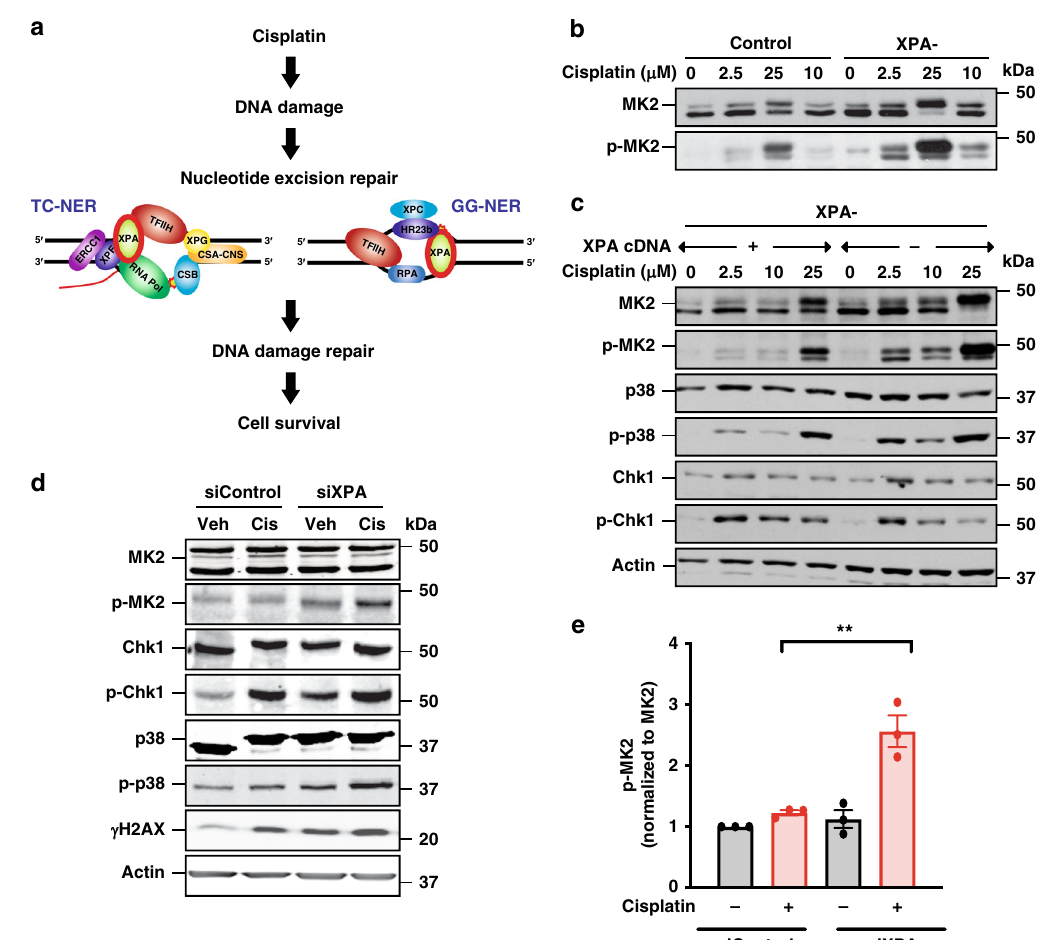
Fig. 1 Cells defective in repair by NER hyperactivate MK2 signaling. a Nucleotide excision repair pathways involved in cisplatin-induced DNA damage. b MK2 activity was assessed by Western blot analysis 24 h after vehicle or cisplatin treatment in control and XPA-de fi cient fi broblasts. Data are representative of two independent experiments. Note the slight activation of MK2 in the XPA de fi cient cells even in the absence of cisplatin treatment. c Western blot of MK2, Chk1, and p38 activation 24 h after cisplatin treatment in XPA-de fi cient fi broblasts transfected with vector control ( − ) or with restoration of XPA ( + ). d Western blot of MK2, Chk1, and p38 activation, and γ H2AX levels, 6 h after vehicle (Veh) or cisplatin (Cis) treatment (25 µ M) in XPA-pro fi cient or de fi cient KP7B cells. Data representative of three independent experiments. The prominent doublet banding pattern of MK2 arises from use of alternative translation start sites in the mRNA 59 . e Quanti fi cation of phospho-MK2 in XPA-depleted KP7B cells. n = 3 independent experiments; ** p = 0.007; two-tailed unpaired t test. Error bars represent mean ±